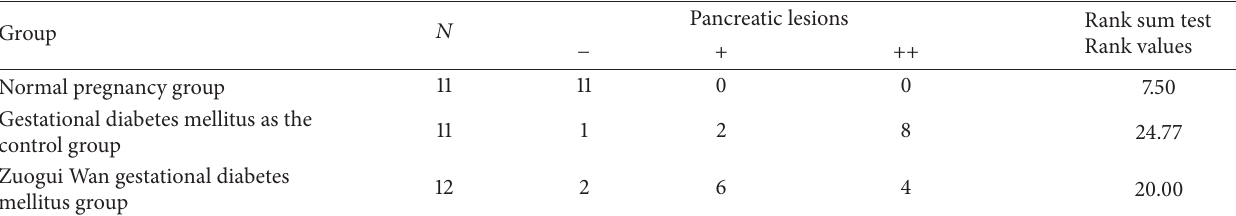
Table 5: Comparison of pancreatic lesions of rats in each